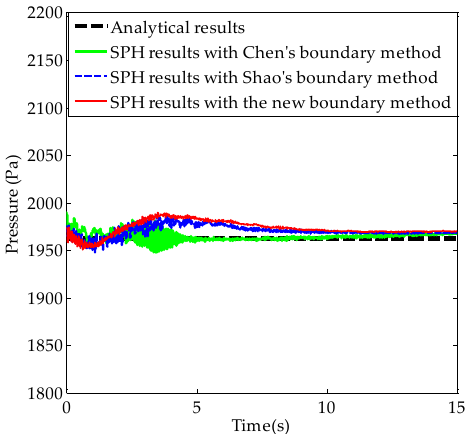
Figure 2. Pressure field and particle distribution at 15.0 s: ( a ) SPH results with Chen’s boundary method ; ( b ) SPH results with Shao ’s boundary method ; ( c ). SPH results with the new boundary method.